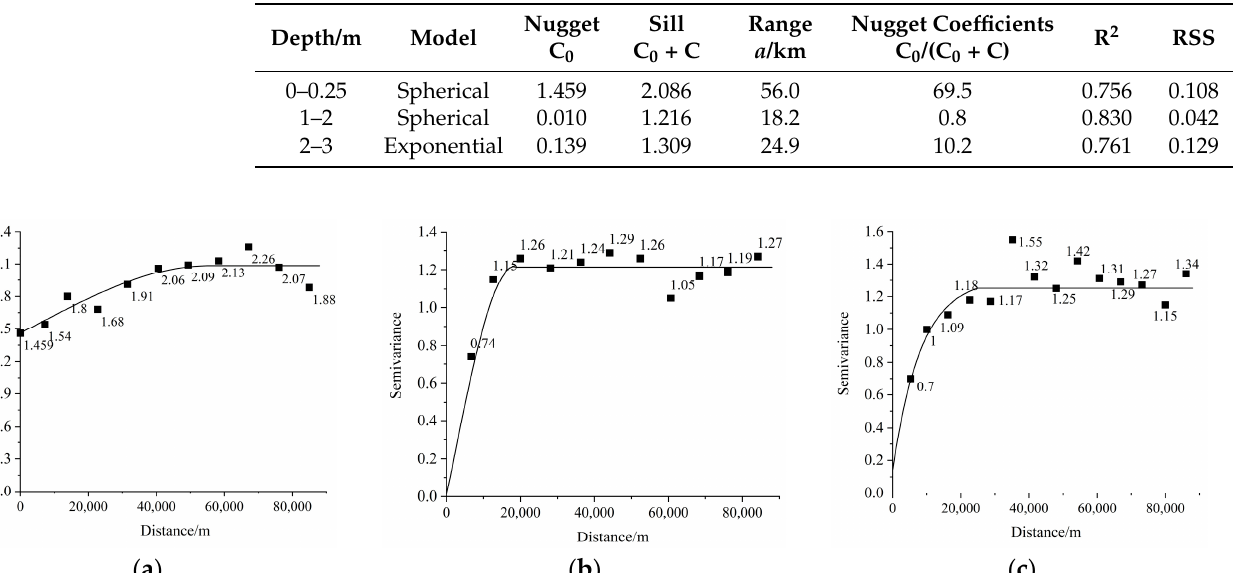
Table 4. Anisotropic parameters of soil salinity at different depths.